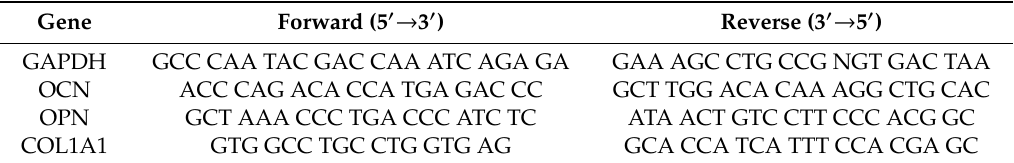
Table 1. Primers used for qPCR: glyceraldehyde 3-phosphate dehydrogenase (GAPDH; reference